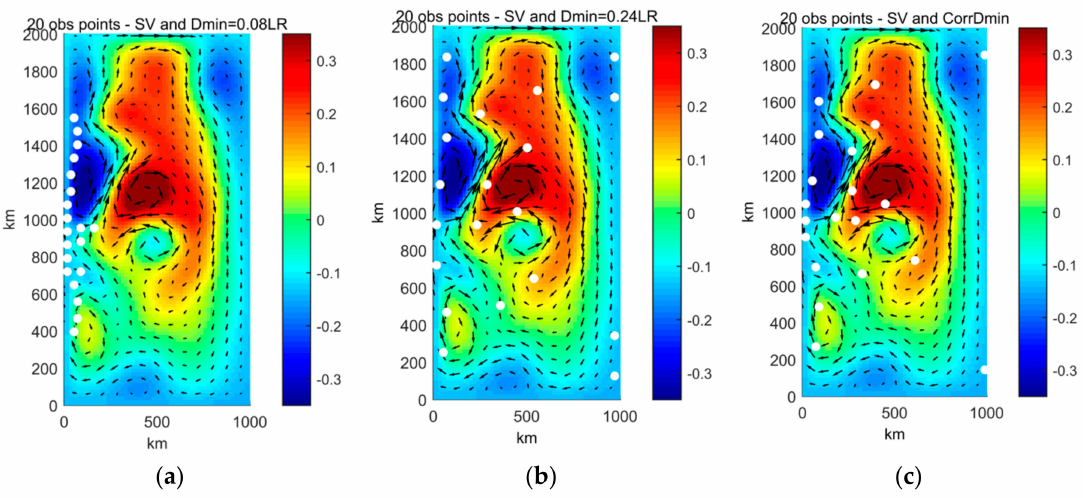
Figure 12. Observation points of dataset selected by the Singular Value Decomposition (SVD)-based procedure imposing a minimum distance of 0.08 LR ( a ), 0.24*LR ( b ), and, finally, produced by the SV-based imposing the correlation distance of Figure 10 ( c ).